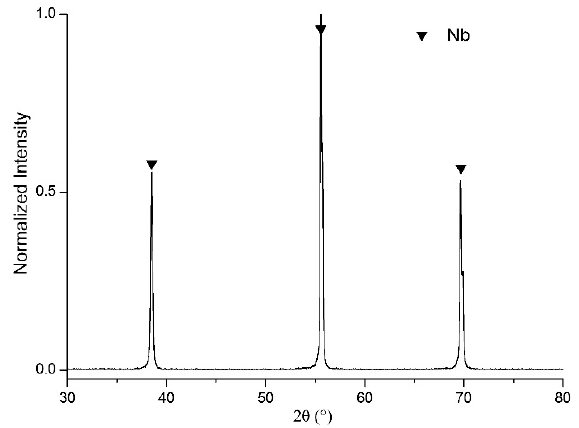
Figure 10. XRD pattern of CPC No. 3.